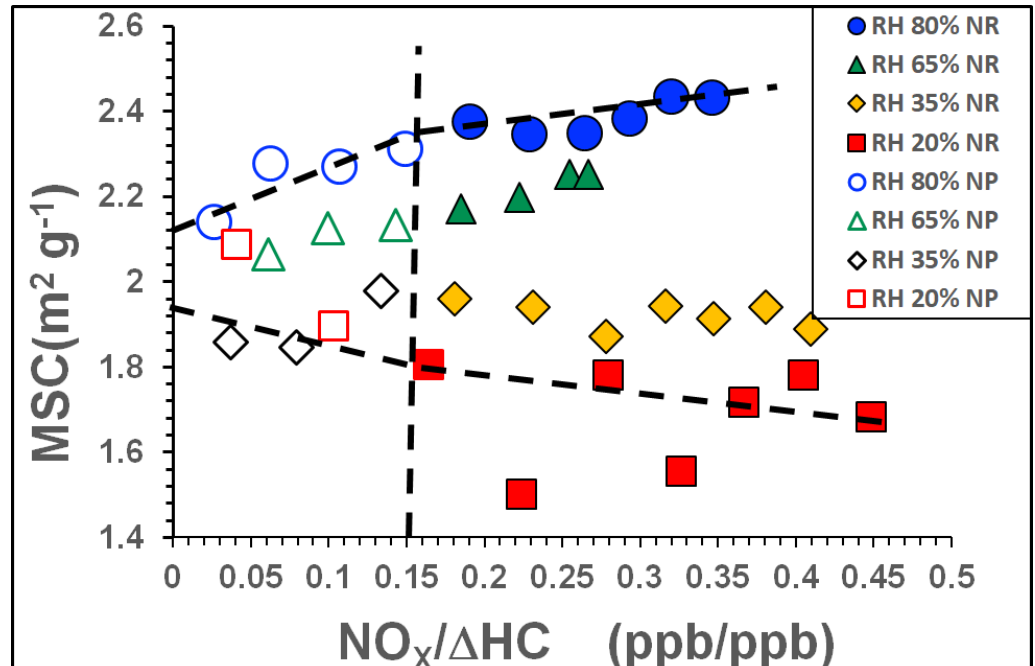
Figure 7. MSC as a function of the NOx to reacted toluene ratio ([NOx]/[ HC]) at 80% RH, 65% RH, 35% RH and 20% RH. Empty and filled symbols show results for NP and NR SOA, respectively. The solid and dashed lines are included to guide the eye.